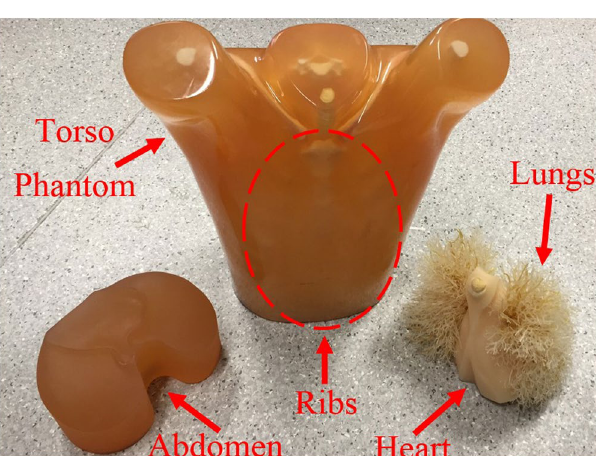
Figure 3. The utilized realistic size torso phantom with disassembled inner